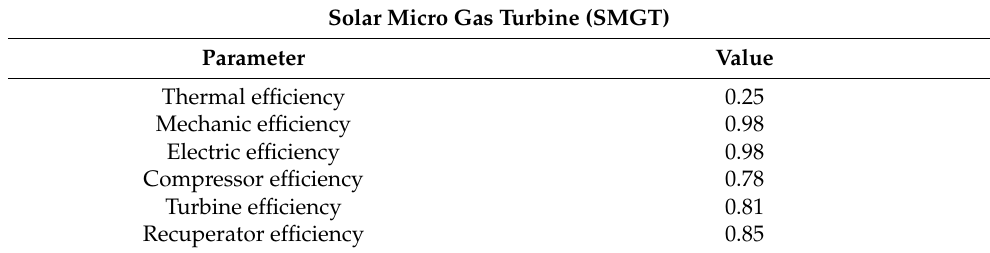
Table 11. Parameters of design of a 10 kW rated power SMGT